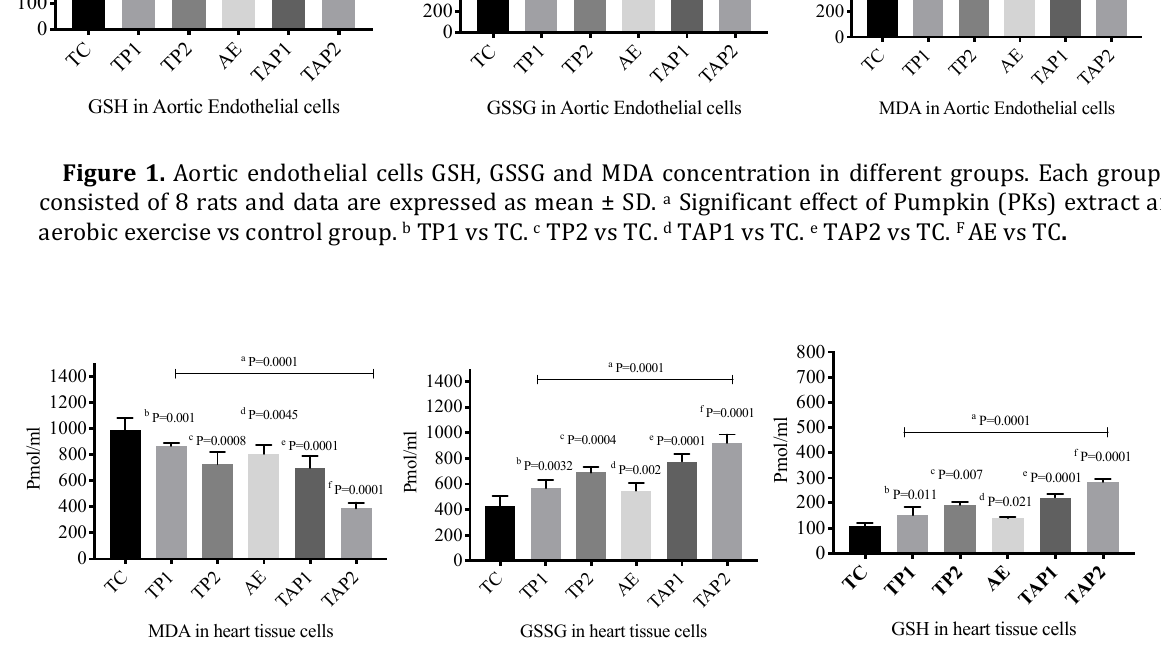
Figure 2. Heart tissue cells GSH, GSSG and MDA concentration in different groups. Each group is consisted of 8 rats and data are expressed as mean ± SD. a Significant effect of Pumpkin (PKs) extract and aerobic exercise